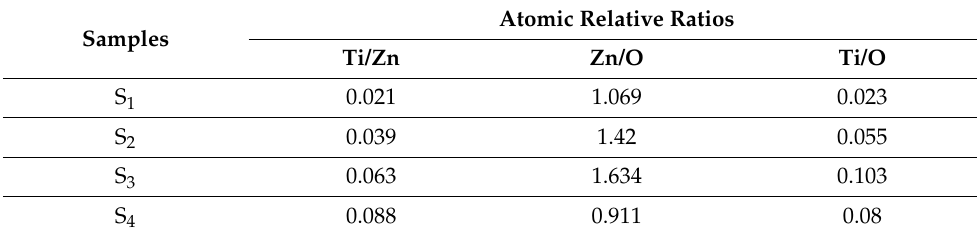
Table 4. The atomic relative ratios for the synthesis for S 1 , S 2 , S 3 , and S 4 . Samples